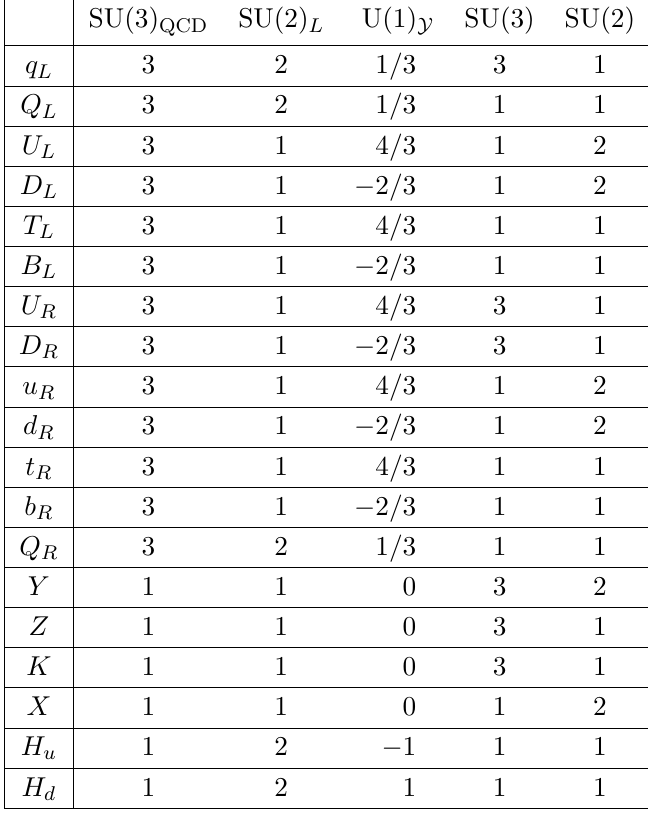
Table 1 . The field content of the model with the G SM × G F quantum number assignments. SU(3) × SU(2) yields the following mass